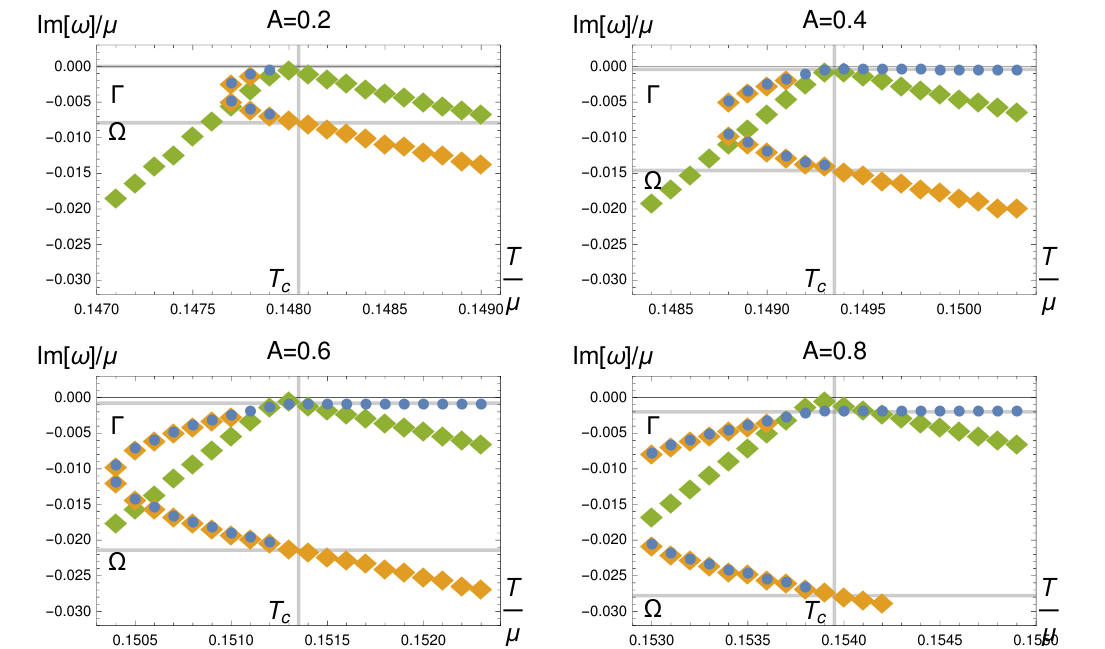
Figure 11. The results for the spectrum of quasinormal modes, obtained for different periodic lattice amplitude. The evolution of the spectrum is clearly visible. The data for Ω and Γ are used to plot the corresponding dependencies on the right panel of figure